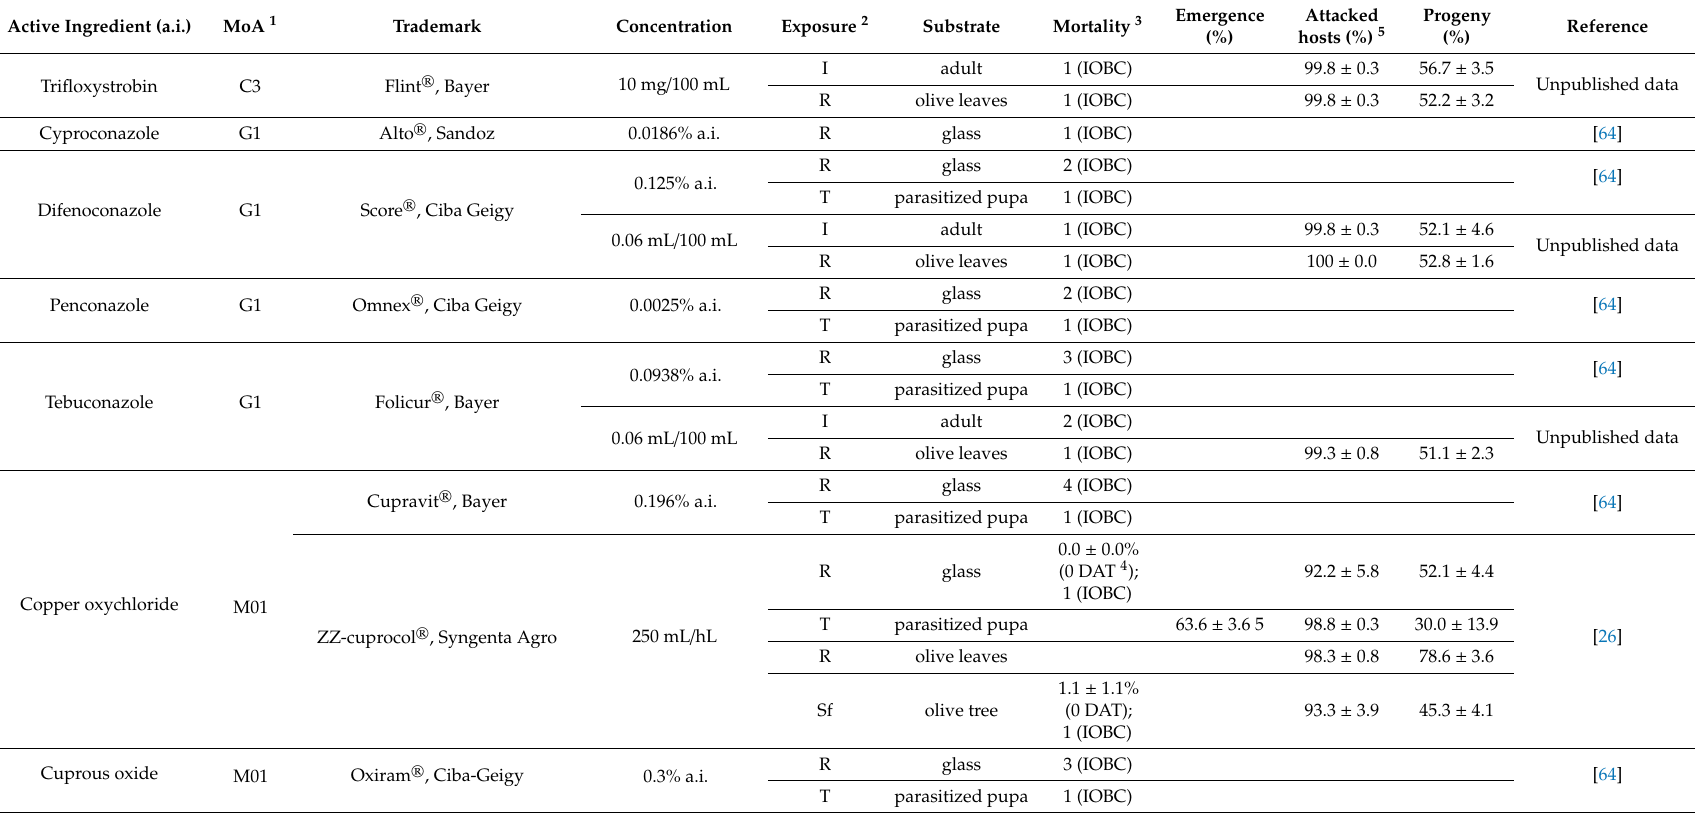
Table 2. Toxicity of fungicides, currently registered in the European Union, tested on Psyttalia concolor adults. Active Ingredient